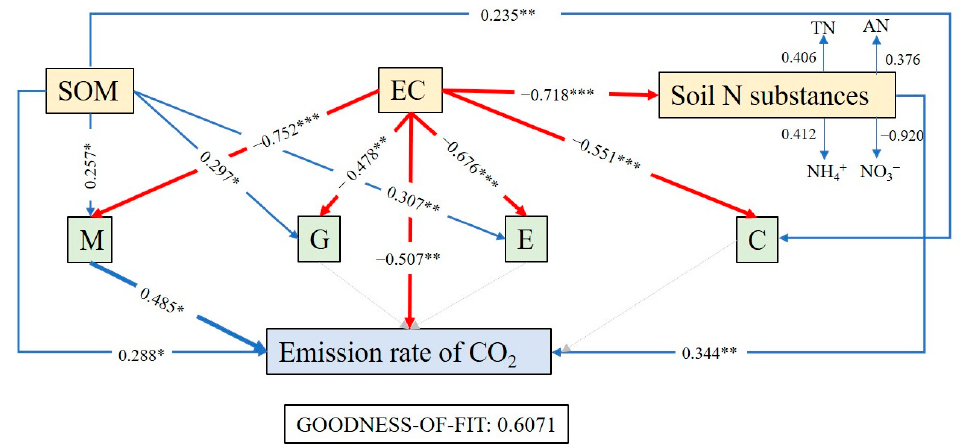
Figure 6. Correlation between soil CO 2 emission rate and bacterial function prediction pathway and soil environmental factors. Notes: Coefficients that differ significantly are indicated by * p ≤ 0.05,